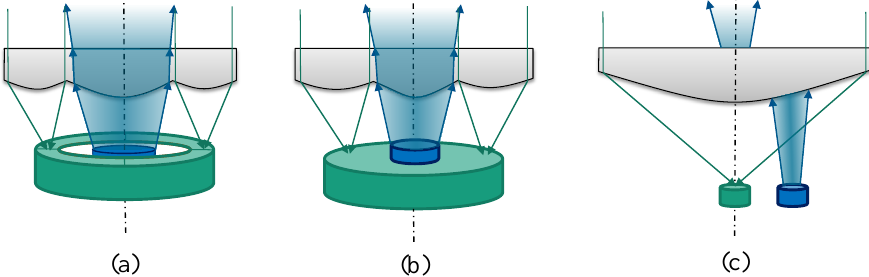
Figure 3. Schematic illustration of different radial separations of TX (blue) and RX (green) with an optical element (grey). ( a ) Direct integration of TX and RX into a plane. ( b ) Stacking an emitter chip onto a PD. ( c ) An optical element is used to homogenize the TX ray bundle and move it to the optical